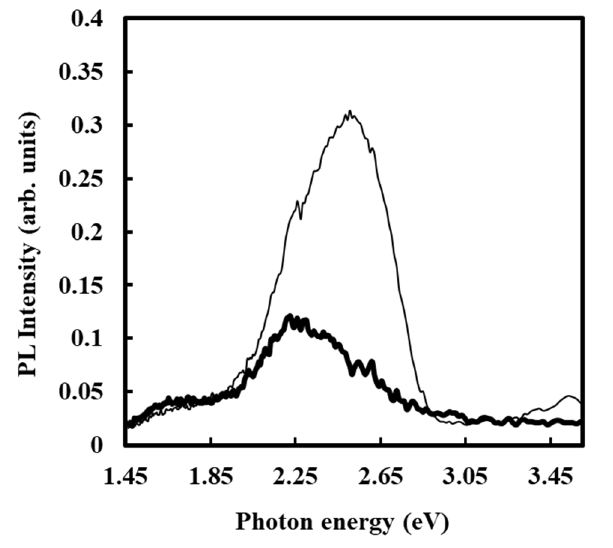
Figure 8. Photoluminescence spectra of the titania thin films on the quartz glass substrate. The lines represent the QCNTESD ( ▬ ) and QSPIN (—).